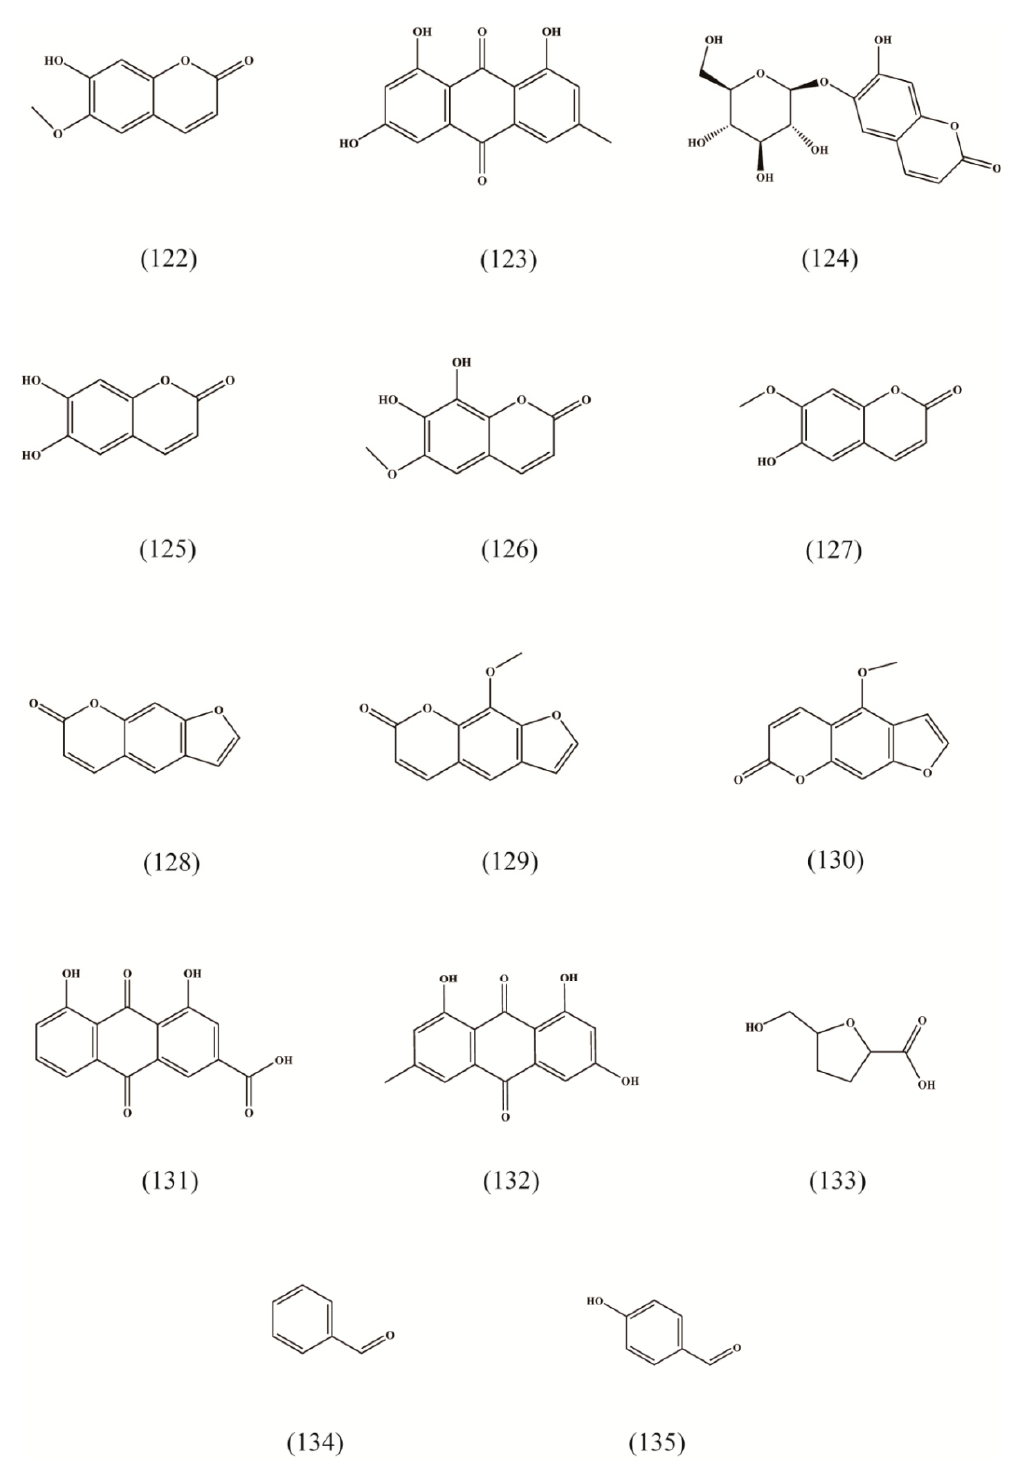
Figure 6. Structures of other compounds isolated from Radix Asteris.